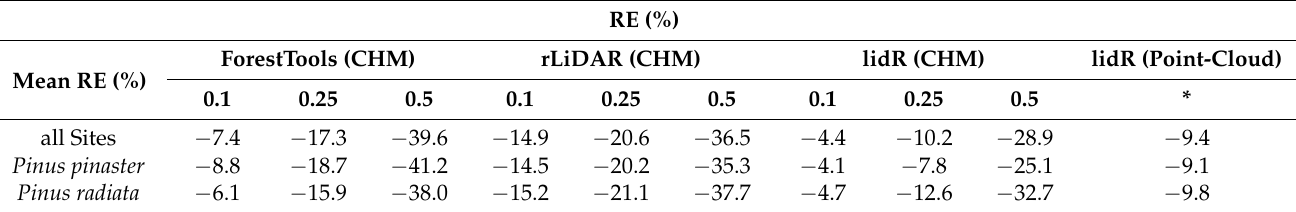
Table 4. Mean relative error (RE in %) of the different combinations of algorithms/plot/species/CHM resolution (“all sites”, refers to the average RE of all evaluated plots. “ Pinus pinaster ” refers only to plots occupied by P. pinaster (A026BEG; A026DOZ; A026FRA), while “ Pinus radiata ” refers to plots occupied only by P.radiata (A028BEG; A028DOZ; A028SAN). A negative RE value indicates that the number of trees detected is being underestimated.